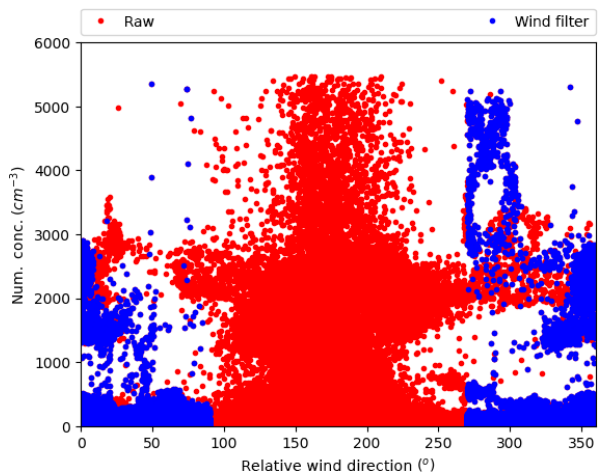
Figure 1. CCN plotted against wind direction (relative to the plat- form) from the RV Investigator voyage IN2016_V03. Red: all raw data. Blue: after data are removed when wind speed is less than 5ms − 1 or relative wind directions between 90 and 270 ◦ . Uncon- taminated data are usually less than 1000cm − 3 – see Fig. A1. Data filtered with just wind measurements still show clear signs of con-